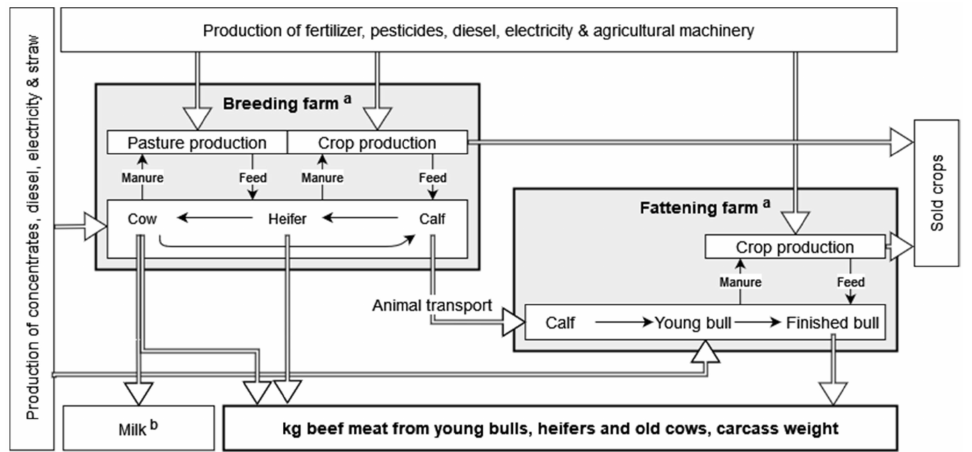
Figure 3. System boundaries of the analyzed beef production systems. Source: adapted from [23]. a in the German system breeding and fattening are integrated in one farm sparing animal transport. b milk is considered a co-product on the dairy farm of the German system and in the system redesign scenario in